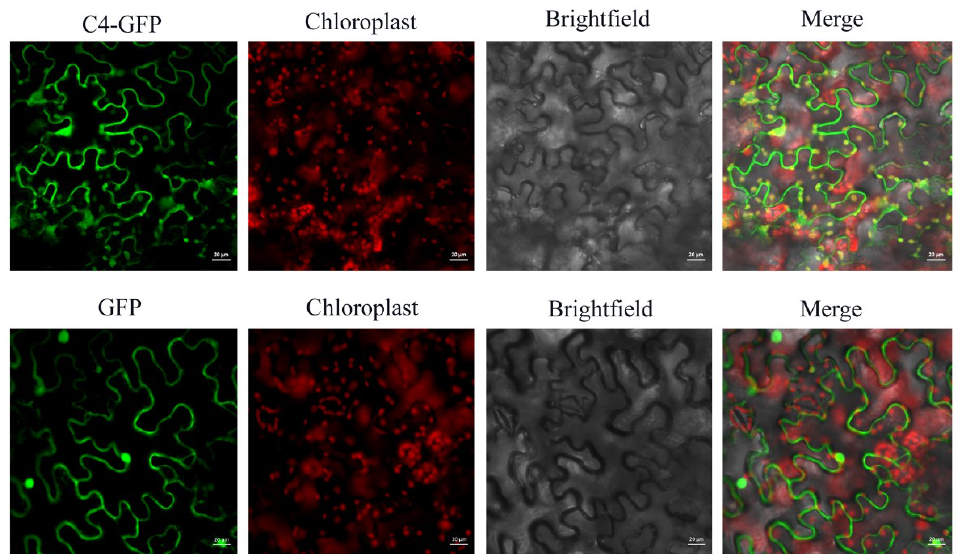
Figure 2. Subcellular localization of AGV C4 in N. benthamiana leaves. The recombinant fluorescent protein C4-GFP expressed from pCam35S-C4-GFP is localized to cytoplasm, plasma membrane, nucleus, and chloroplasts, which is different from the free GFP from pCam35S–GFP distributed evenly in the cytoplasm and nucleus. Chloroplasts are identified by the auto-fluorescence of chlorophyll through laser excitation of 561 nm. Confocal laser scanning images were taken approximately 3 d post infiltration. Scale bars indicated in the photos represent 20 μm.